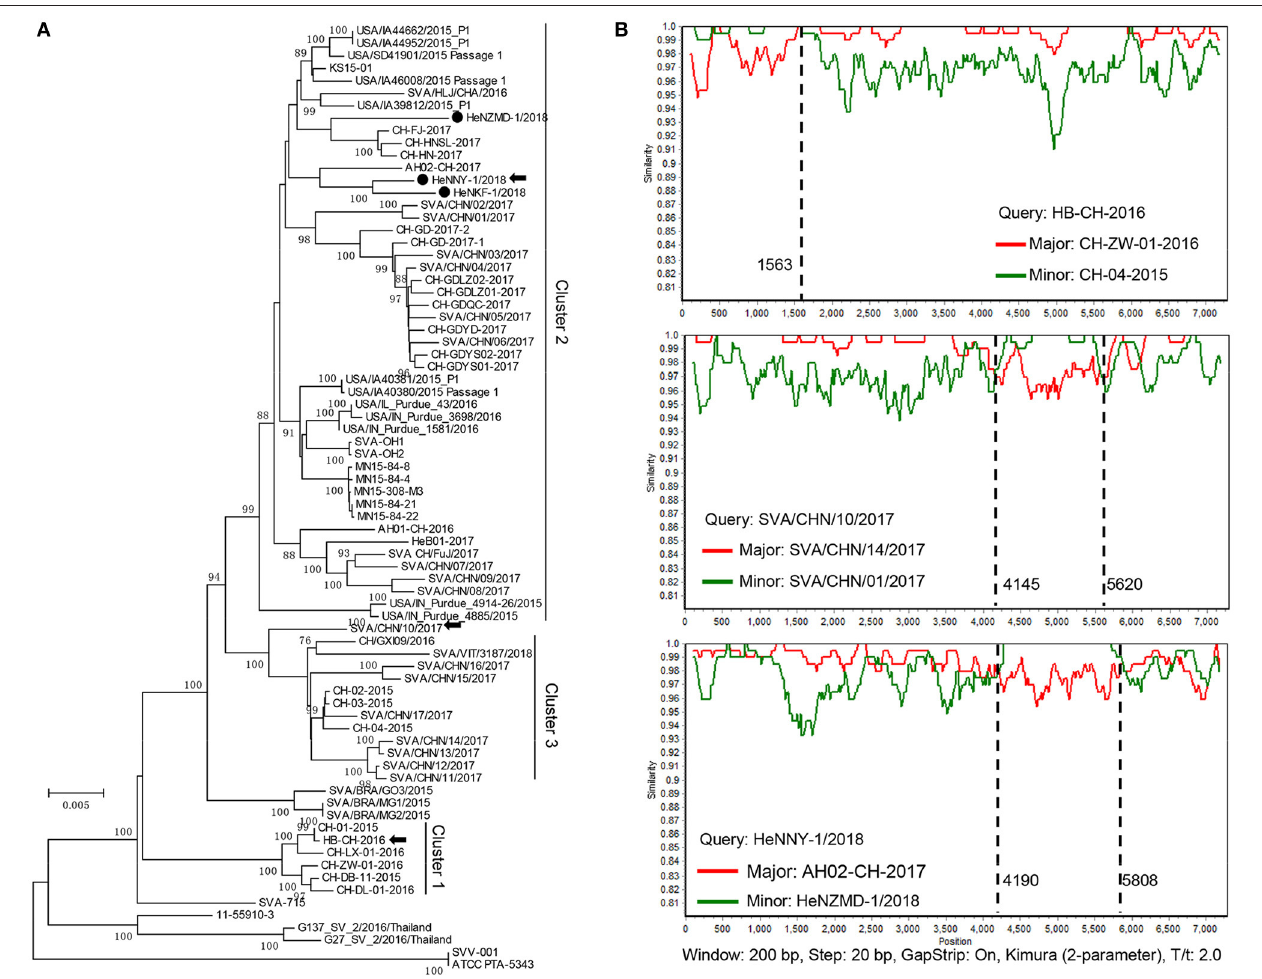
FIGURE 2 | Phylogenetic and recombination analysis of complete SVA genomes. (A) Reported SVA strains from China could be divided into 3 clusters. Phylogenetic trees were constructed with MEGA 6.0 software using neighbor-joining method, with 1,000 bootstrap replicates. Newly isolated strains are marked by black solid circles (•). Recombinant strains are indicated with black arrows. (B) Recombination analyses of SVA strains in this study. Crossover regions were identified by RDP4 and SimPlot 3.5.1 softwares. The X-axis shows the location of the query strain, and the Y-axis indicates the percentage of similarity. Reference strain, the major parental strain (red) and the minor parental strain